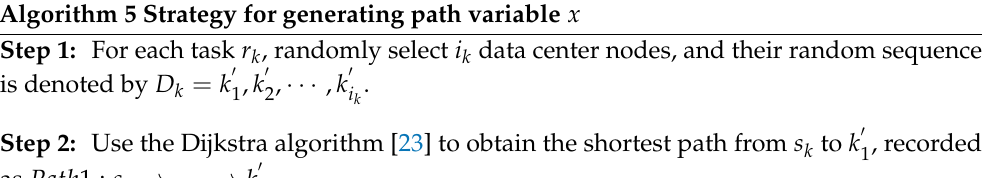
Algorithm 4 Another evolutionary algorithm for the model